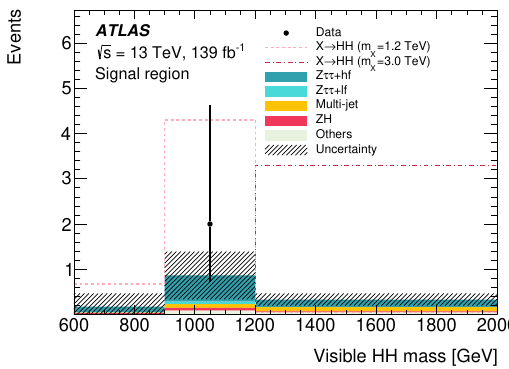
Figure 12. Distributions of m vis after applying all the event selections that define the HH SR, HH except the requirement on m vis . The background labelled as ‘Others’ contains W +jets, diboson, t ¯ t HH and single-top-quark events. The X → HH → b ¯ bτ + τ − signal is overlaid for two resonance mass hypotheses with a cross-section set to the expected limit, while all backgrounds are pre-fit. The first and the last bins contain the underflow and overflow bin entries, respectively. The hatched bands represent combined statistical and systematic